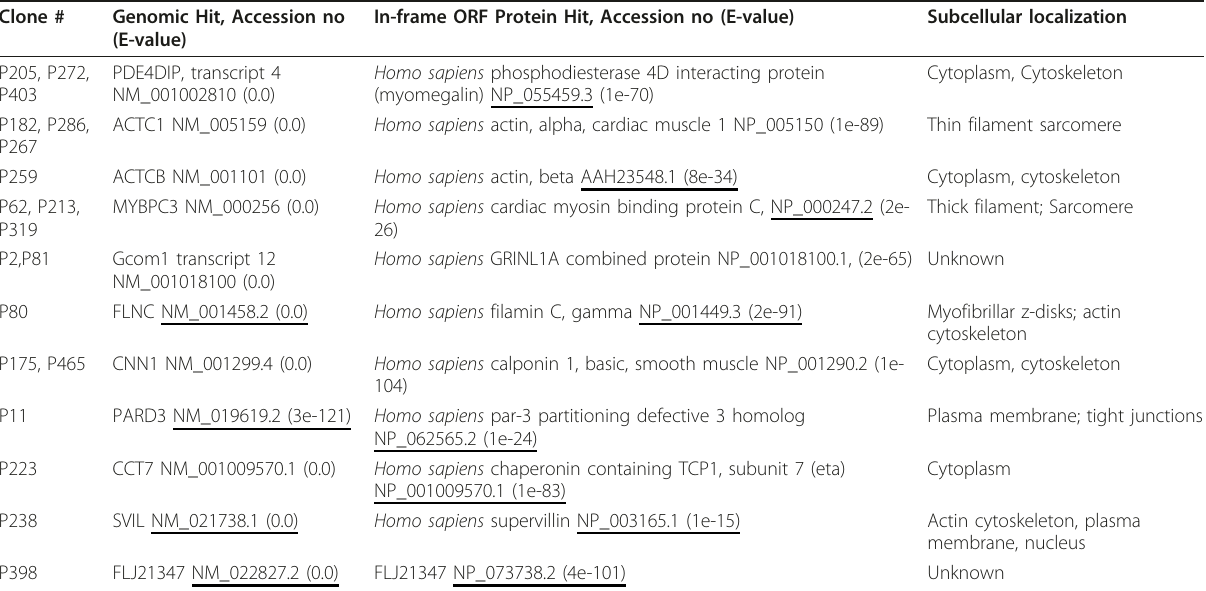
Table 1 Interactors of the C1-C2 region of cMyBPC in the trisphospho-mimic state as identified by yeast 2-hybrid library